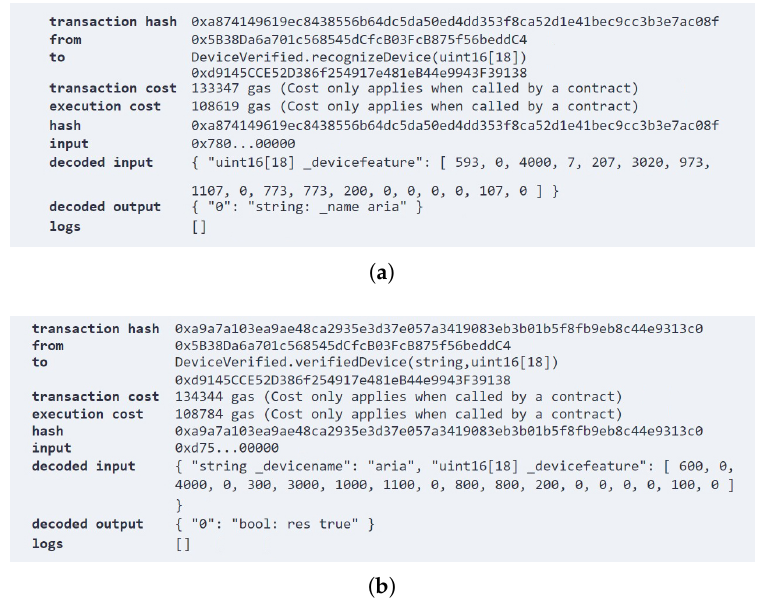
Figure 8. ( a ) Execution results of Register() . ( b ) Execution results of Detective()